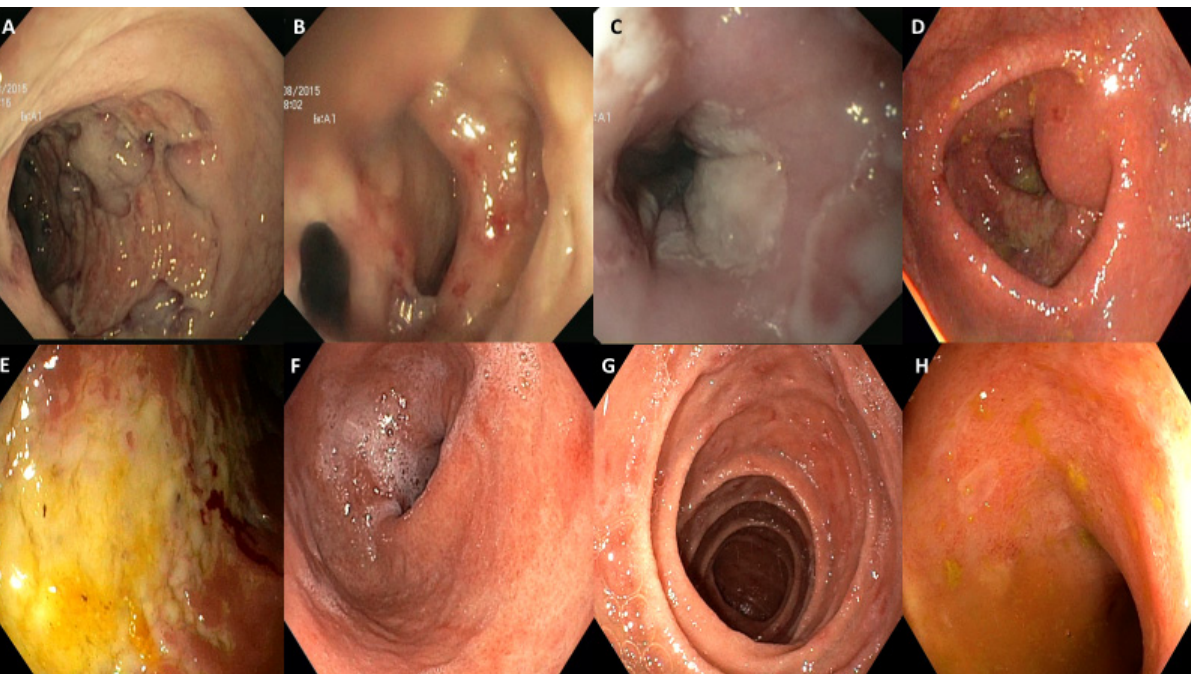
Figure 1. Spectrum of endoscopic findings. ( A ) Deep colonic ulceration. ( B ) Colonic fistula, demonstrated by double lumen. ( C ) Esophageal exudates not associated with Candida infection. ( D ) Colonic erythema, with friability and reduction in the vascular pattern. ( E ) Colonic exudates and mucosal hemorrhage. ( F ) Gastric erythema. ( G ) Duodenal erosions. ( H ) Ileal erosions.